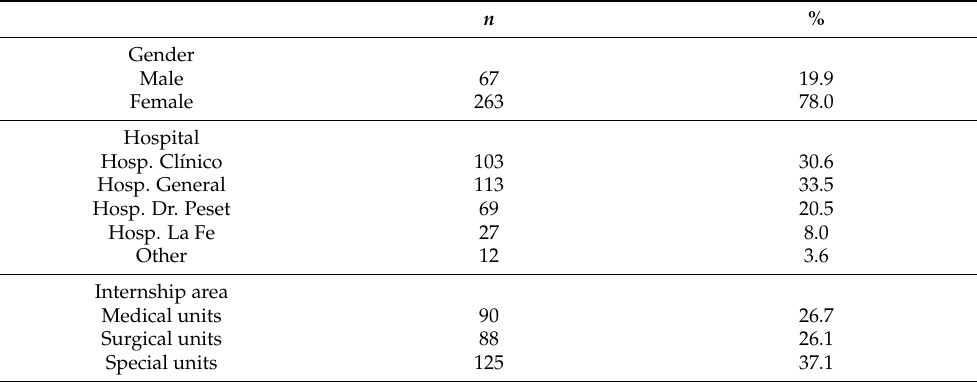
Table 1. Characteristics of the participants ( n =